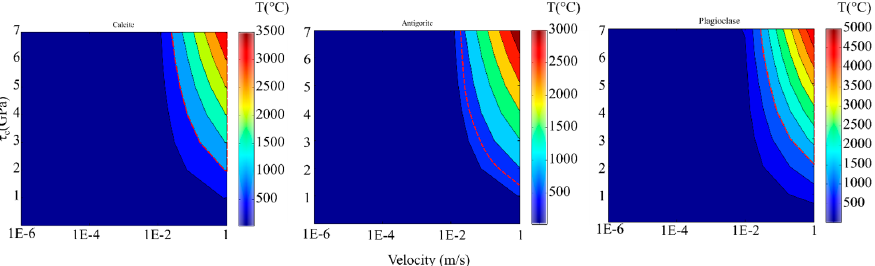
Figure 3. Temperature estimation at the asperities as a function of the ultimate shear strength and velocity resulting from the flash heating model (Equation (1)) using the thermal parameters in Table 1. From left to right, case for calcite (most abundant mineral in Carrara marble), antigorite (most abundant mineral in the tested serpentinite), and plagioclase (most abundant mineral in microgabbro). The results of the numerical simulation in Figure 3 are consistent with weakening at V w greater than few cm/s where the temperatures at the asperity contacts reach the conditions for the triggering of chemical reactions and phase transitions for the three lithologies examined here. Decomposition